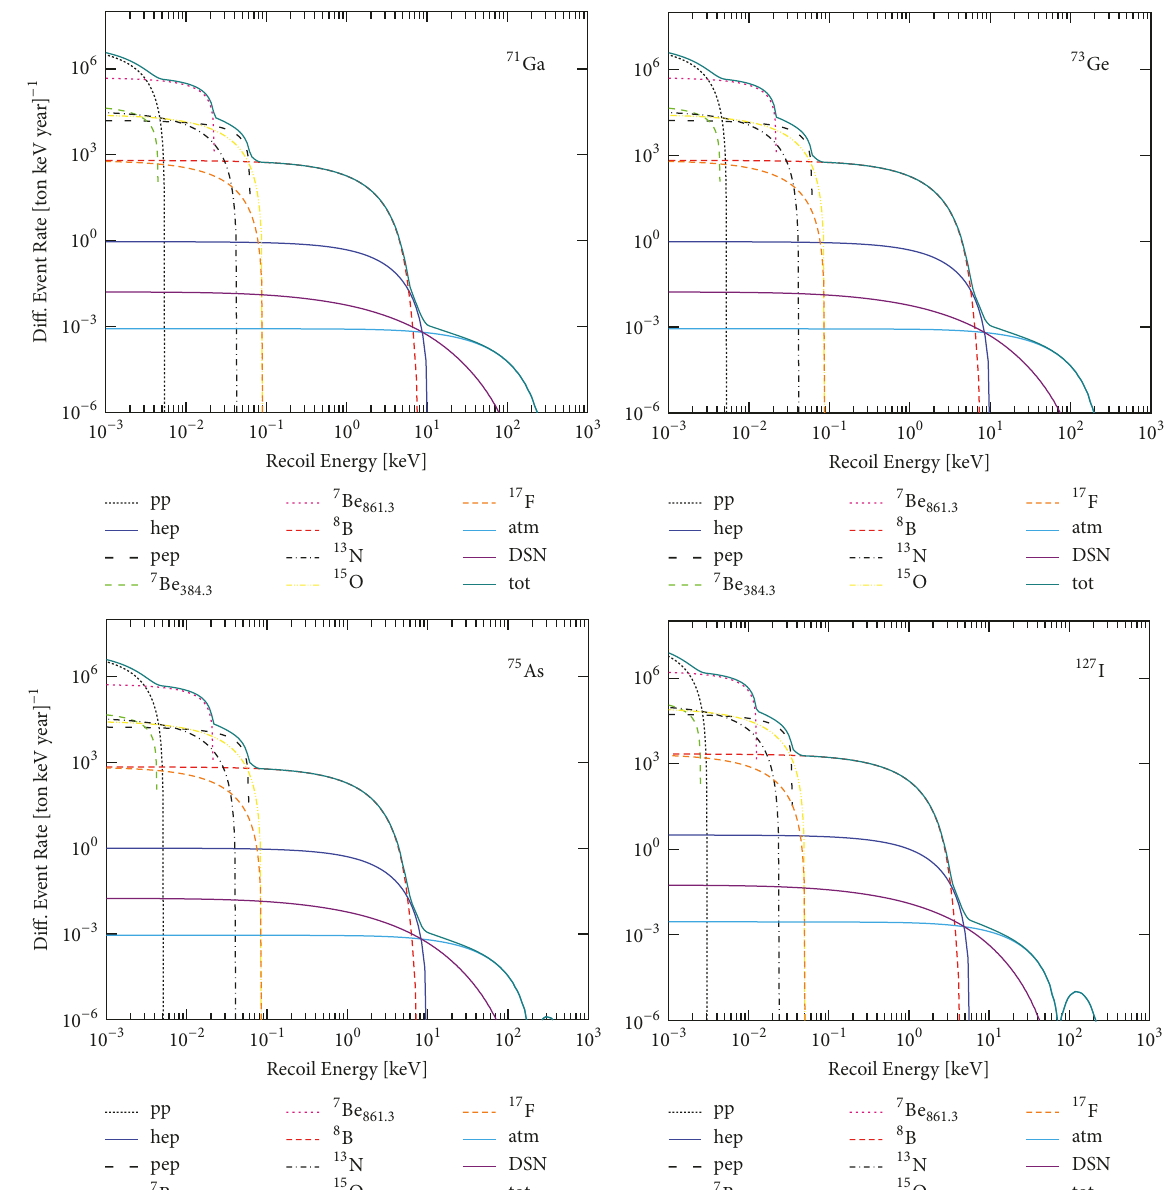
Figure 9: Differential event rate of the neutrino-floor assuming 71 Ga, 73 Ge, 75 As, and 127 I as cold dark matter detectors. The individual components coming from the Solar, Atmospheric, and DSNB flux are also